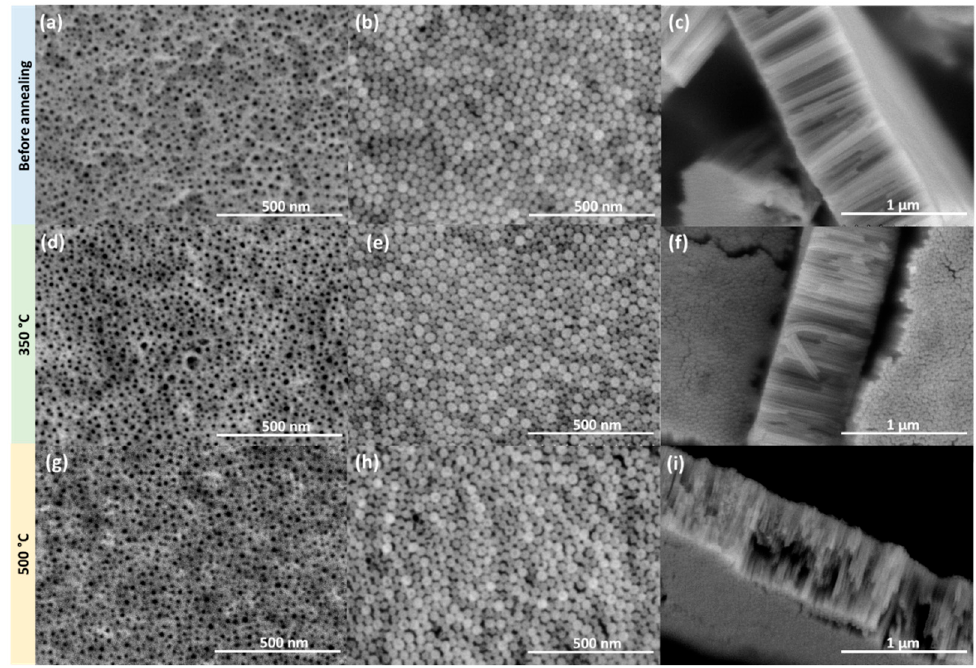
Figure 2. SEM top view ( a , d , g ), bottom view ( b , e , h ) and cross-sectional view ( c , f , i ) images of na- noporous ZrO 2 layers before ( a–c ) and after annealing at 350 °C ( d–f ) and 500 °C ( g–i ).